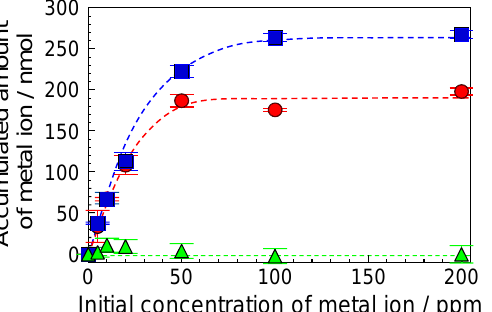
Figure 5. Accumulated amounts of Cu(II) ions (closed circle), Y(III) ions (closed square), and Ca(II) ions (closed triangle). The incubation time was 6 h. Each of the values represents the mean of three separate determinations ± standard deviations. Dotted lines indicate the assumed accumulated amount.